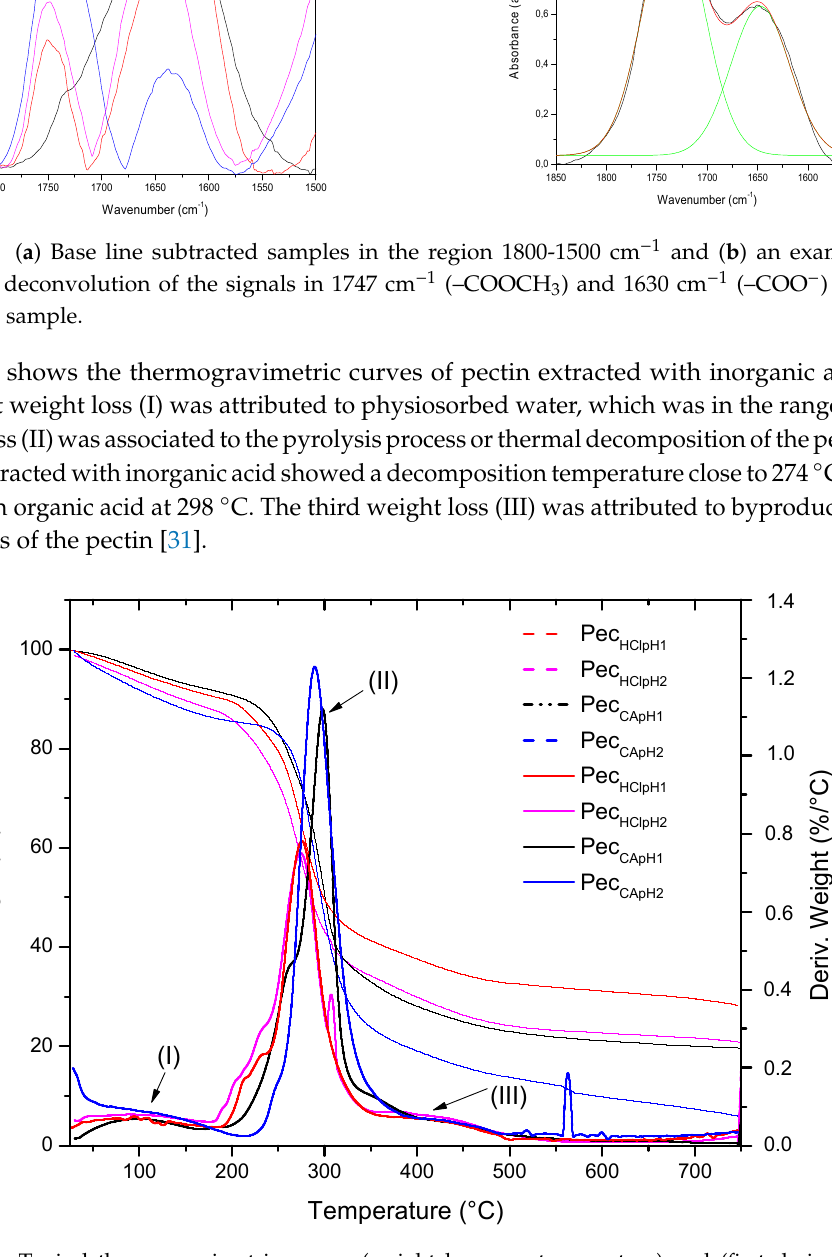
Figure 3. Typical thermogravimetric curves (weight loss vs. temperature) and (first derivative vs. temperature) for pectin extracted with inorganic and organic acid: ---- Pec HClpH1 , ---- Pec HClpH2 , ---- Pec CApH1 , ---- Pec CApH2.